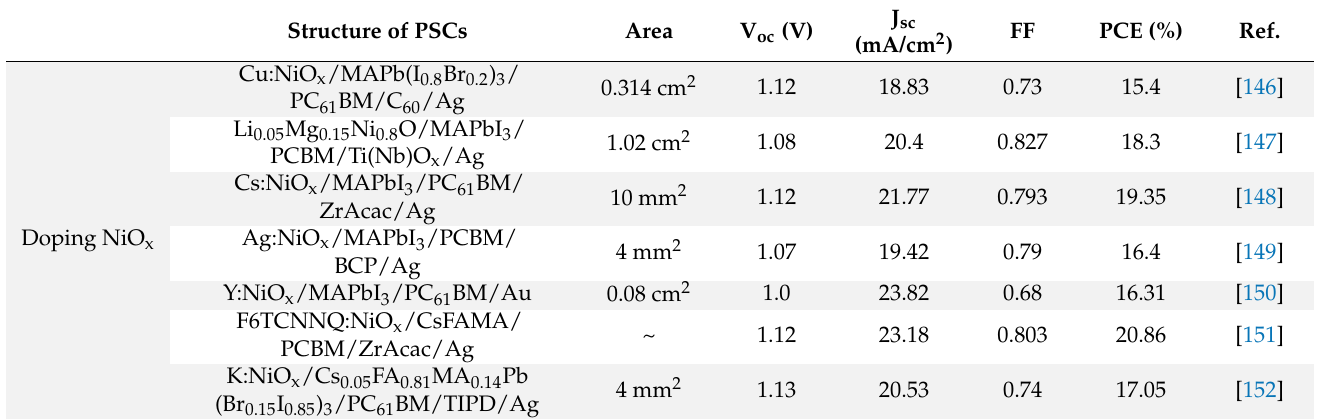
Table 13. Performances of several representative inverted PSCs on the basis of doping NiO x HTL. Structure of PSCs Area V oc (V)